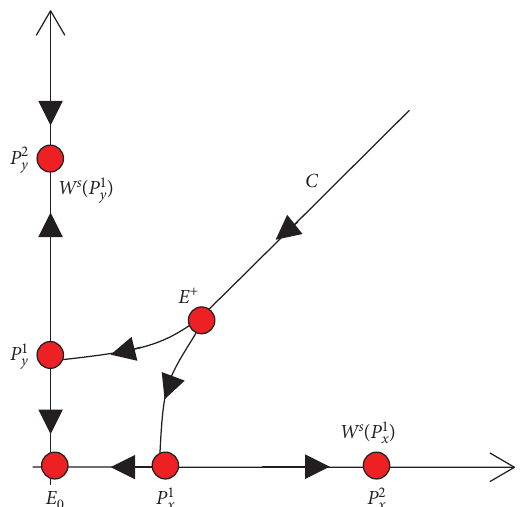
Figure 7: Global manifolds and basins of Theorem